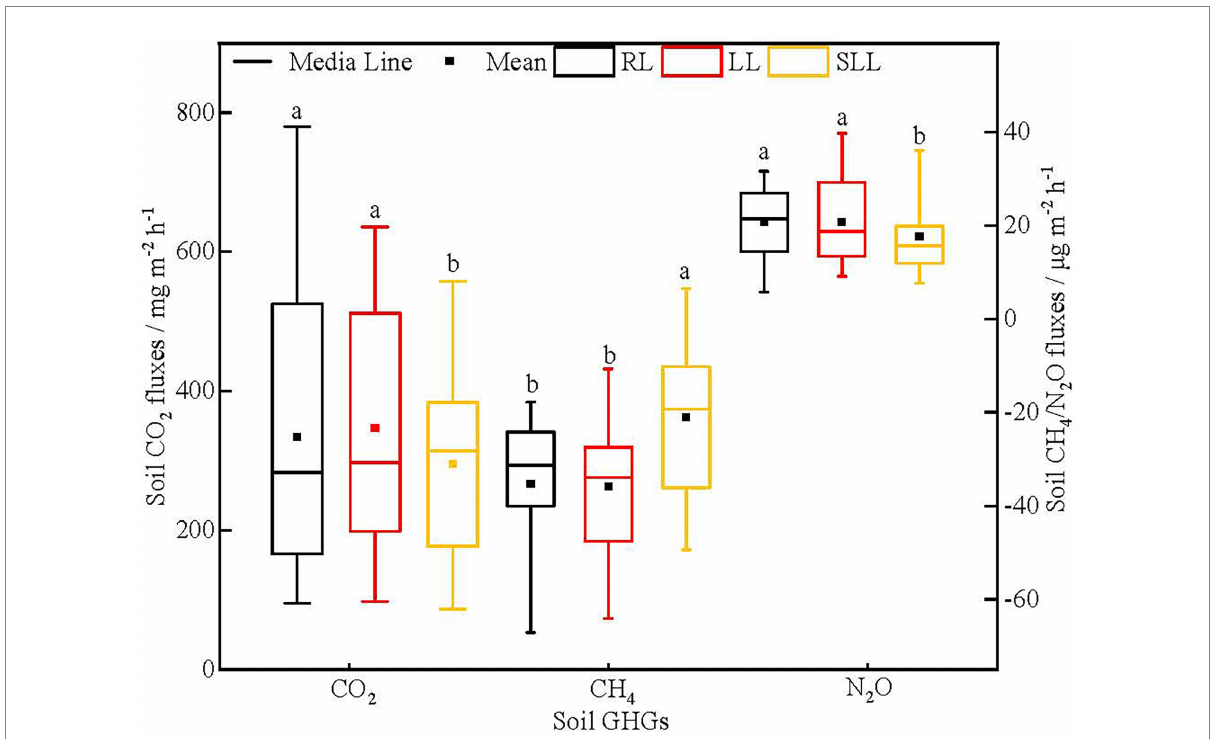
FIGURE 2 Variations in soil GHG fluxes among three types of larch forest. The different lowercase letters (a, b) indicate significant differences among three types of larch forest. Abbreviations: LL, Ledum palustre-Larix gmelinii forest; RL, Rhododendron dauricum-Larix gmelinii forest; and SLL, Sphagnum-Bryum-Ledum palustre-Larix gmelinii forest.